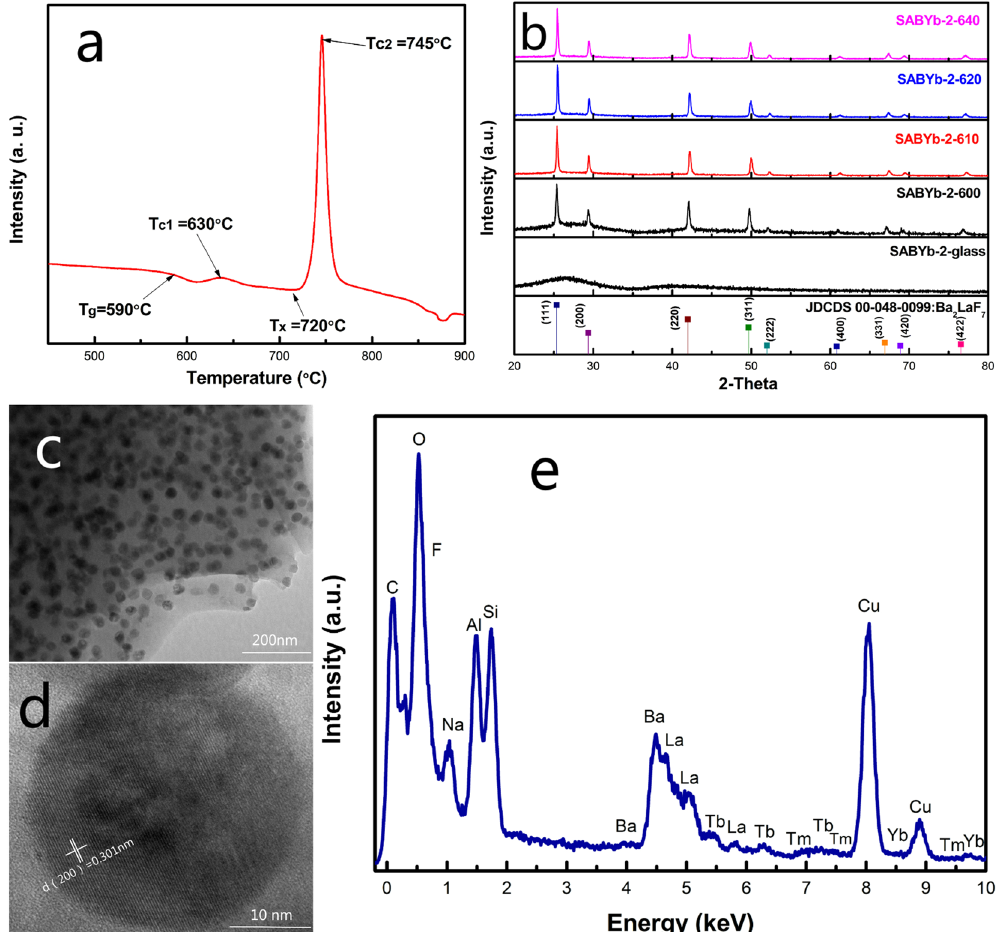
Figure 1. ( a ) The DTA curve of the SABYb-2 glass sample. ( b ) XRD patterns of the SABYb-2 glass and glass- ceramics after heat treatment at 600 °C, 610 °C, 620 °C and 640 °C for 2 h. ( c ) TEM micrograph of SABYb-2 glass-ceramics after heat-treated at 640 °C for 2 h. ( d ) High resolution transmission electron microscope (HRTEM) image of SABYb-2 glass-ceramics. ( e ) EDX spectra from an individual Ba 2 LaF 7 nanocrystal.